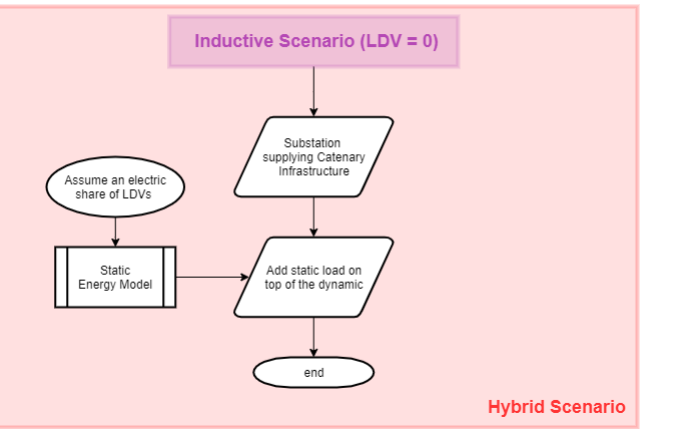
Figure 5. Methodology for the hybrid scenario. For power flow calculations, it is assumed that the charging station is located at the nearest point from the distribution substation on the highway, supplied by one of the cables stretching from it, as is shown in Figure